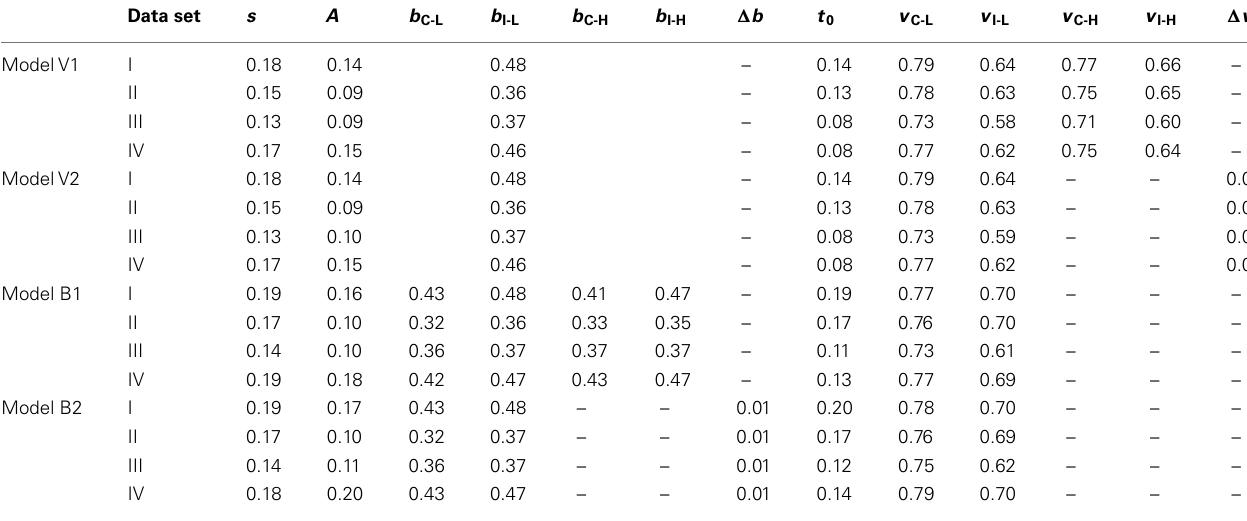
Table 1 | Parameter values for ModelsV1 andV2 (“drift” models) and Models B1 and B2 (“threshold” models) averaged across participants in data sets I, II, III, and